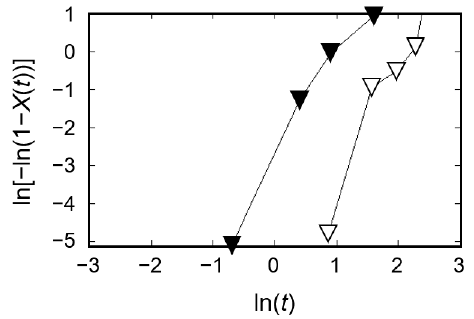
Figure 6. Avrami plots obtained from wide-angle X-ray scattering (WAXS) data: micromolding process (i) with crystallization from the molten state is represented with white triangles, while micromolding process (ii) with crystallization from the amorphous state is represented with black triangles.